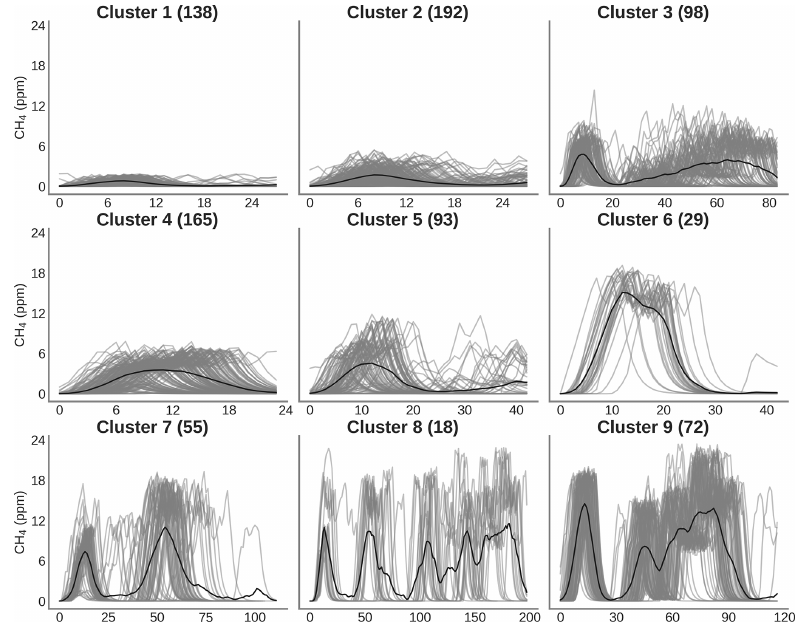
Figure A9. Clustering of peaks using DTW on the reference instrument for the same spikes detected by sensors on chamber C. On the title of each plot, the number inside the parentheses correspond to the number of spikes attributed to each cluster. Thin gray lines represent all the peaks inside each cluster, and the black line is the mean of all the peaks corresponding to each